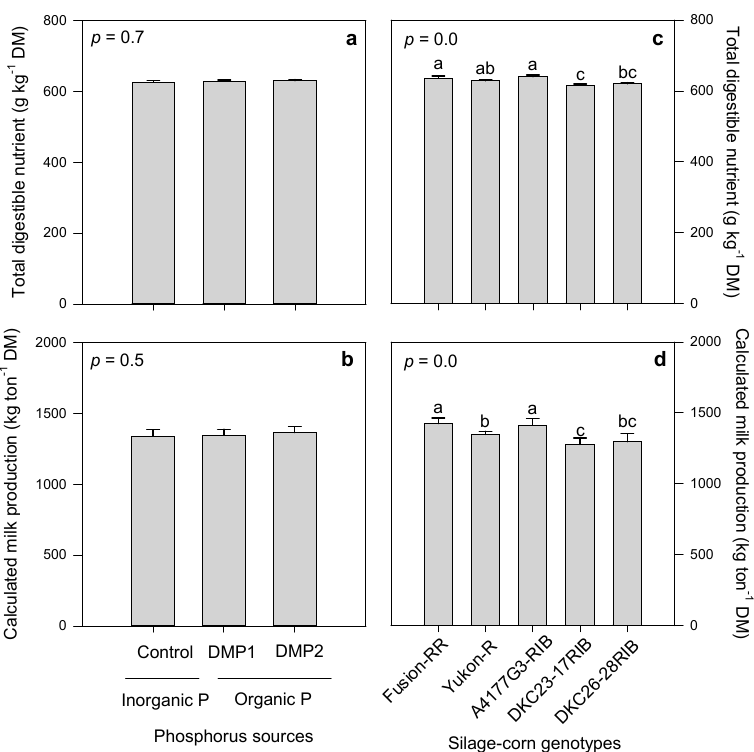
Figure 7. E ff ects of inorganic and organic phosphorus amendments on forage total digestible nutrients ( a ) and calculated milk production ( b ). Variations in total digestible nutrients ( c ) and calculated milk production ( d ) among silage-corn genotypes grown in boreal climate. Each bar represents mean of three replications ± SE.